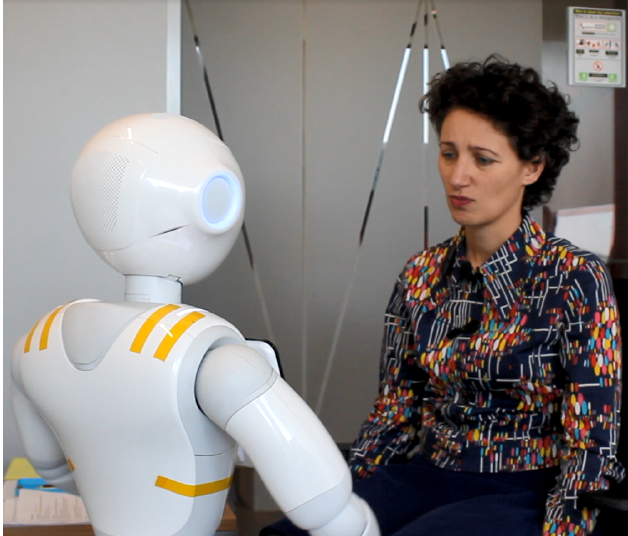
Figure 4. An actress interacting with a CoZ powered Pepper robot during a